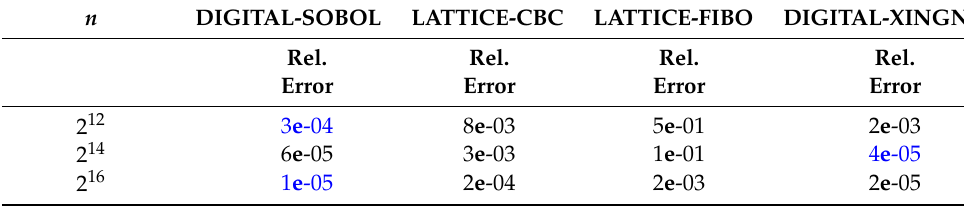
Table 9. RE for AE of D ≈ 0.0025.